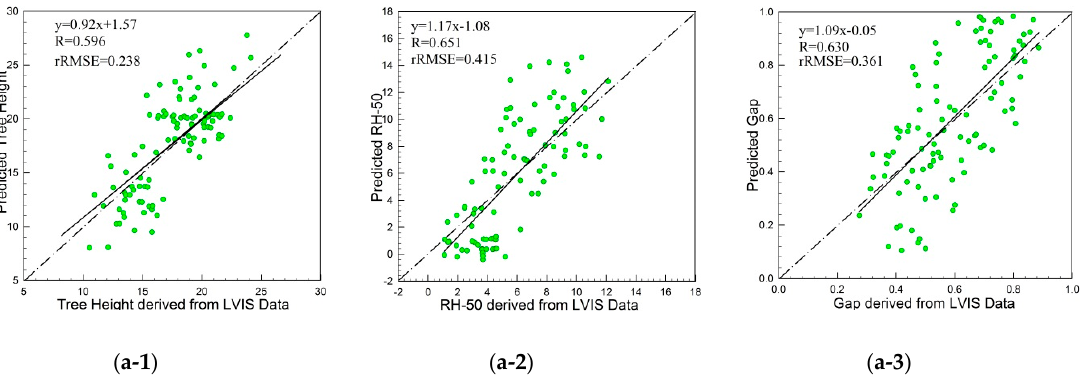
Figure 12. Scatterplots for tree height and gap values derived from the LVIS versus those predicted by the NDMM index at near-infrared band for sparse confer forests in Howland. ( a-1 ) represent scatterplots for tree height values derived from the LVIS vs. predicted tree height; ( a-2 ) represent scatterplots for RH-50 values derived from the LVIS vs. predicted RH-50; ( a-3 ) represent scatterplots for gap values derived from the LVIS vs. predicted gap.